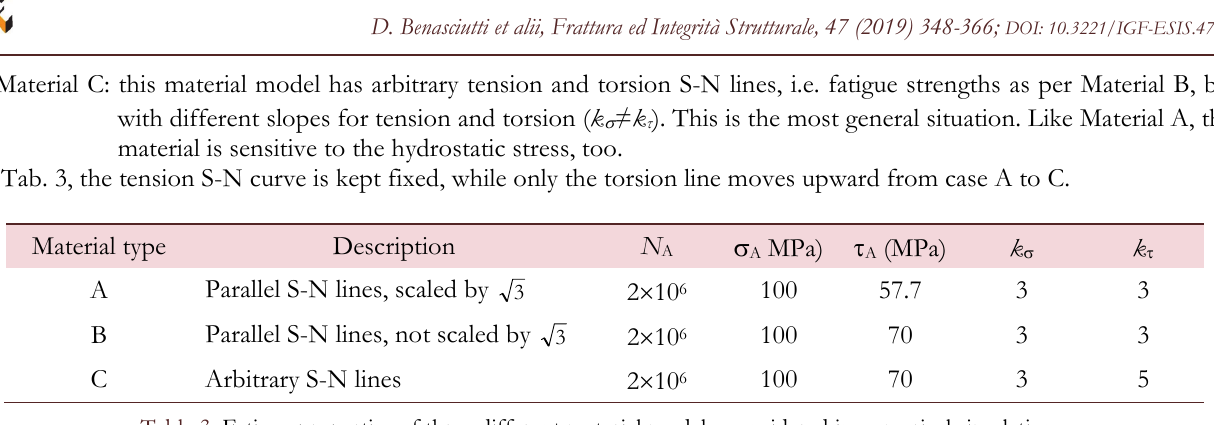
Table 3: Fatigue properties of three different material models, considered in numerical simulations.